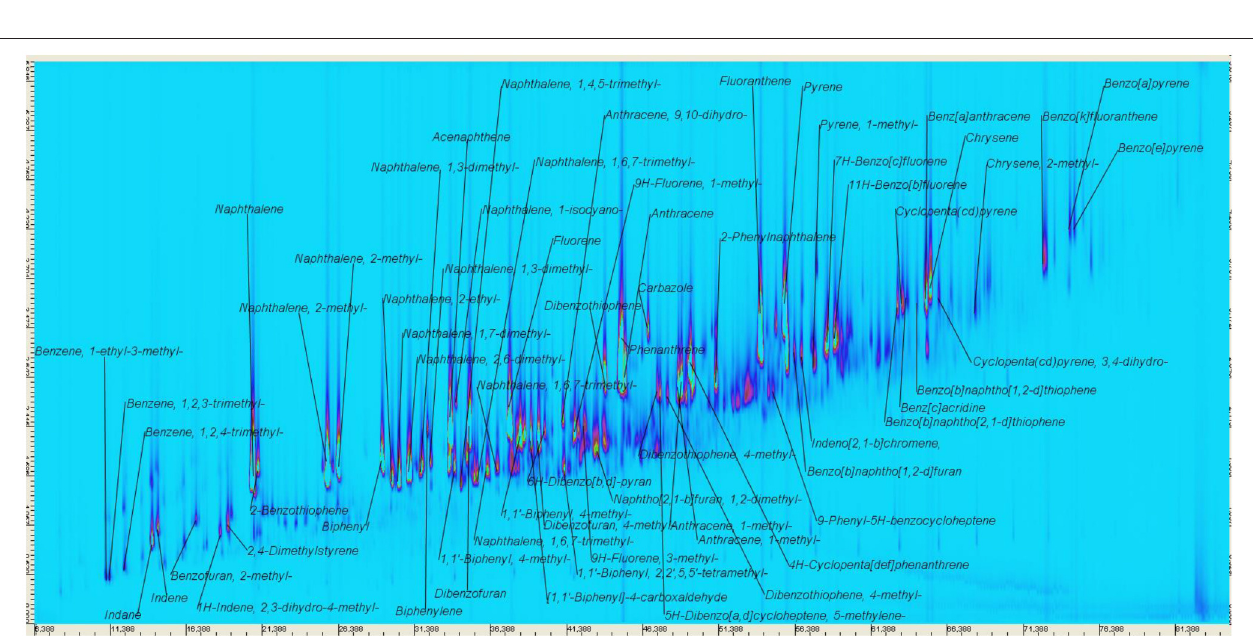
FIGURE 1 | GC-FID Chromatogram of coal tar DNAPL sample from well foot. Some compounds are identified based on their retention time and mass spectra determined via analysis of the same sample using GC-MS. For abbreviations, see Materials and Methods section. Modified from Scherr et al. (2016), reused with permission from Elsevier.